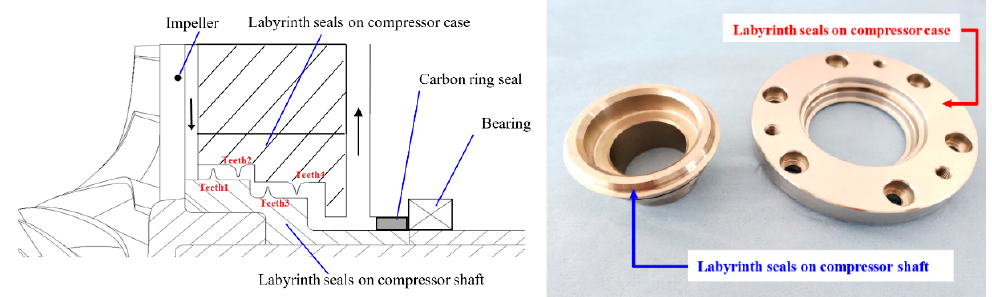
Figure 18. The stepped staggered labyrinth seal used in the SCO 2 centrifugal compressor.